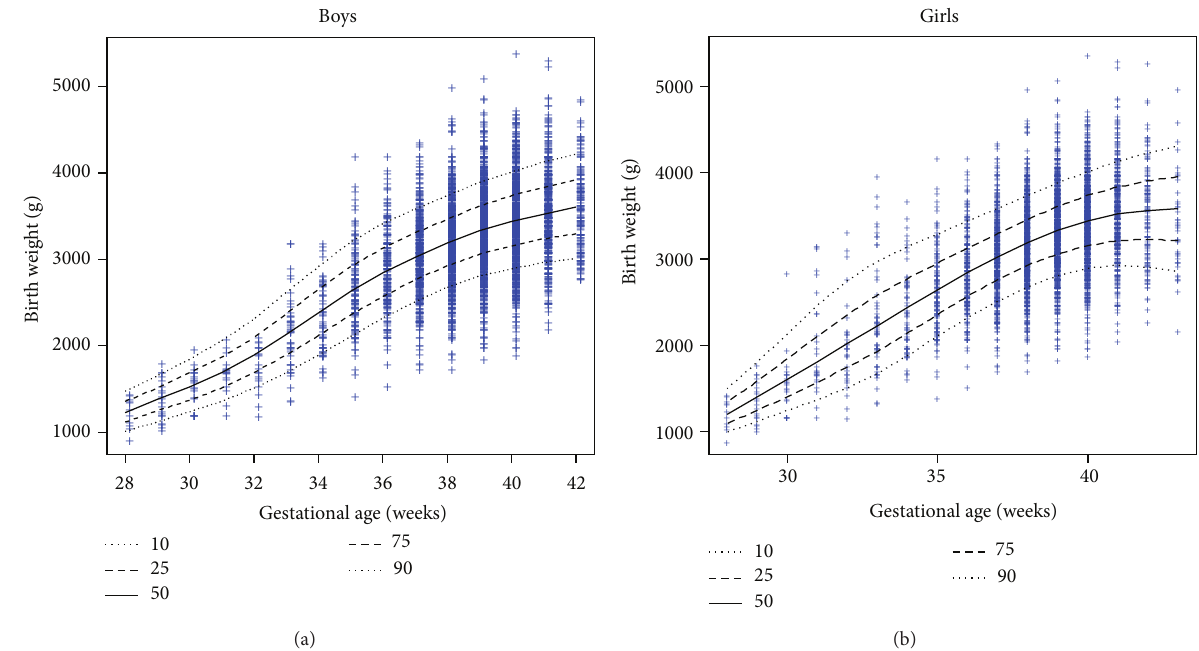
Figure 4: Smoothed percentile curves for the birth weights of male and female Cameroonian infants.